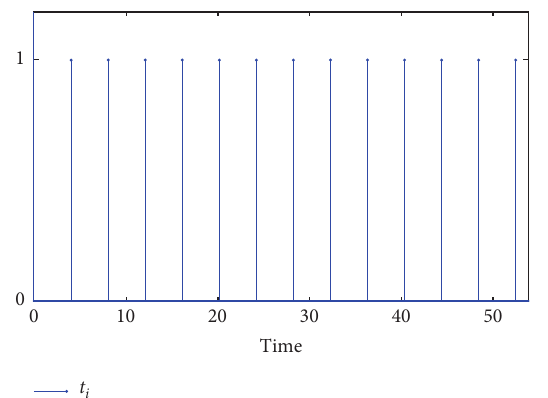
( i � 1 , 2 ) of system (112) under the i